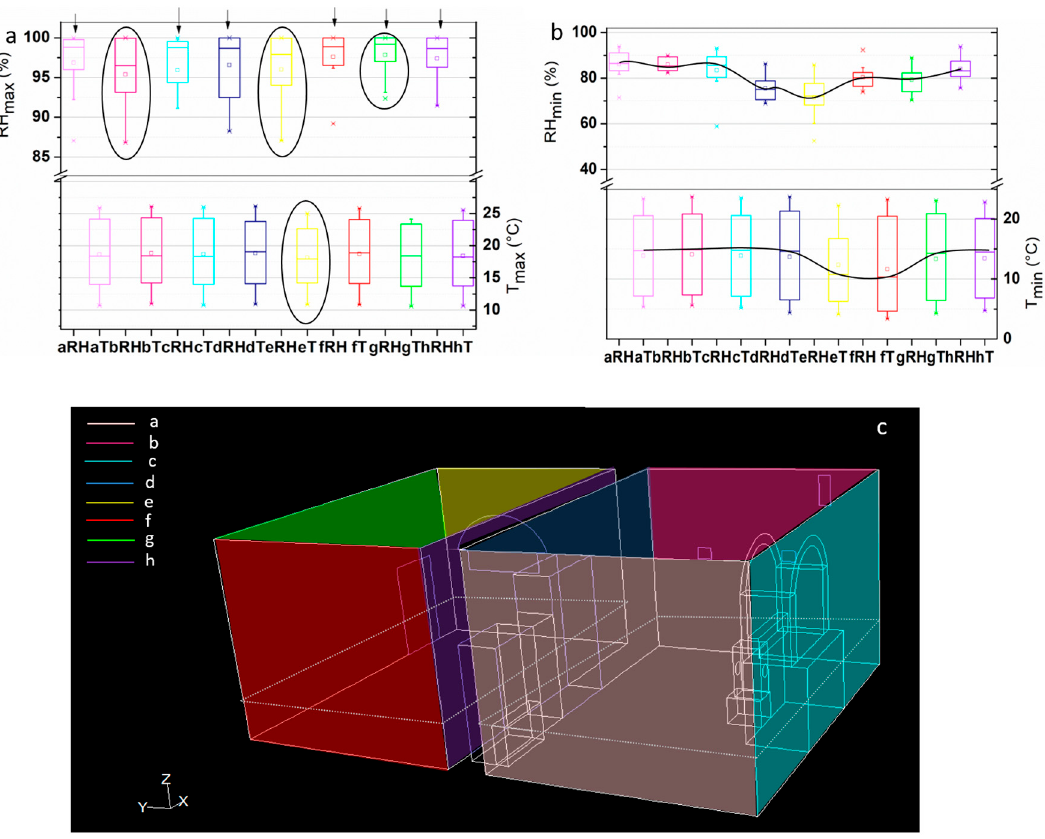
Figure 4. ( a ) Box & Whisker Tmax and RHmax; ( b ) Box & Whisker Tmin and RHmin; ( c ) 3D representation. The colors are according with the wall belonging.